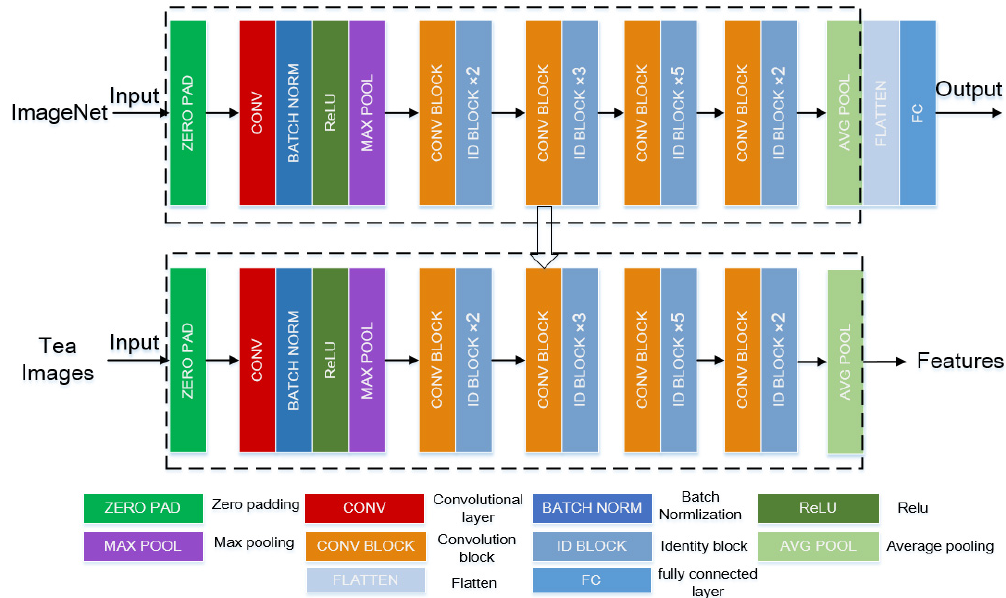
Figure 3. The framework of the Resnet50. The Resnet50 model trained on ImageNet, which is transferred to the target dataset, and the last convolutional layer is used as a high-level features output